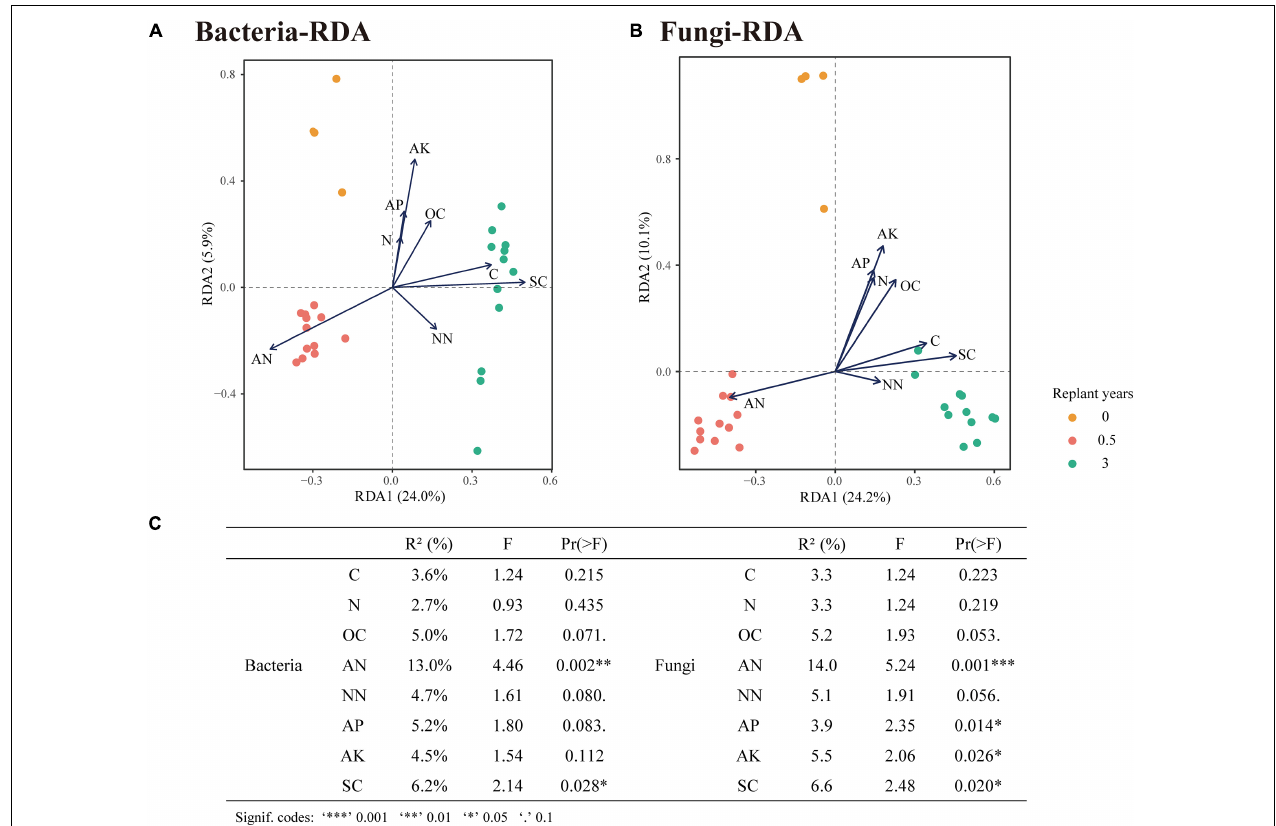
FIGURE 6 | Correlations between soil physicochemical properties and rhizosphere microbial species. (A,B) RDA of bacterial and fungal community profiles correlated to soil properties. (C) Explanation rate of soil physicochemical properties to the differences of community profiles (conditional effect).